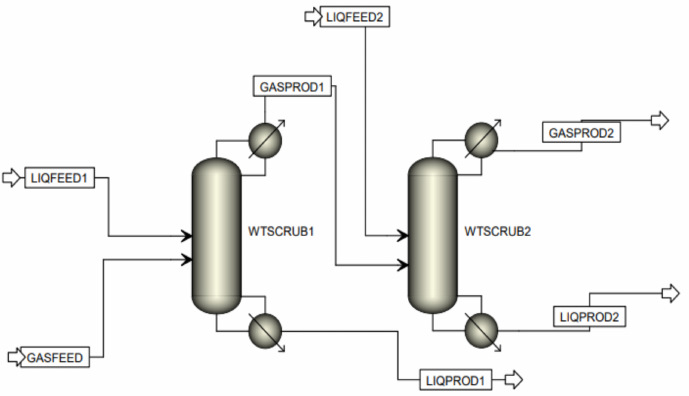
Figure 4. Wet scrubbing process Aspen Plus ® flowsheet